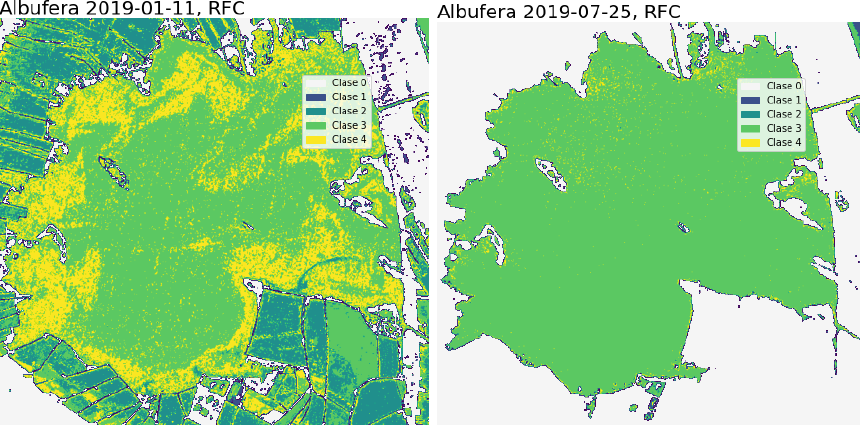
Figure 9. Albufera of Valencia lagoon: temporal analysis of water changes using RF